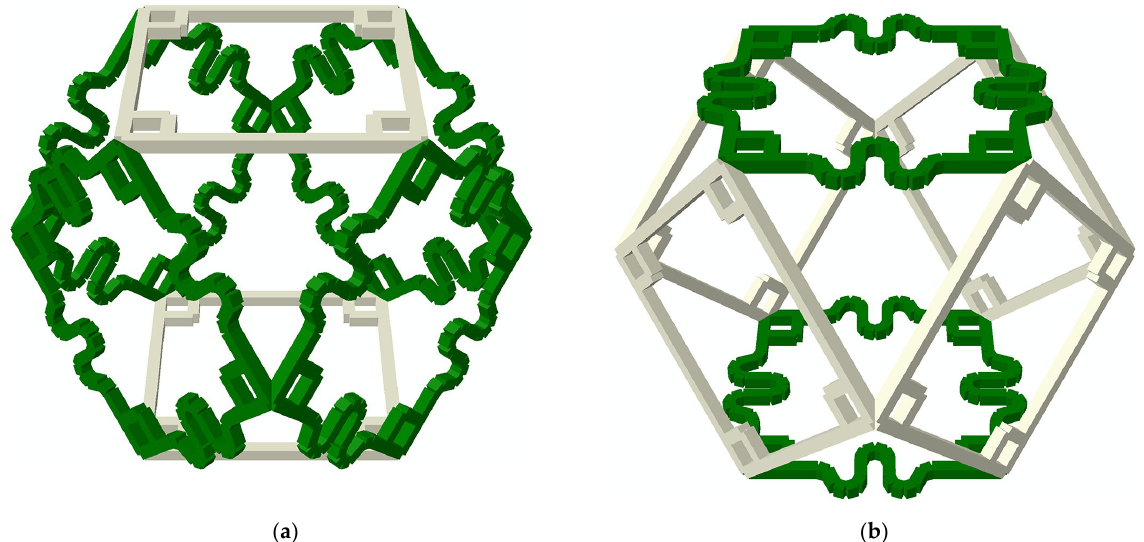
Figure 13. Two types of derived passive cells: ( a ) Tensile cell; ( b ) Bending cell.